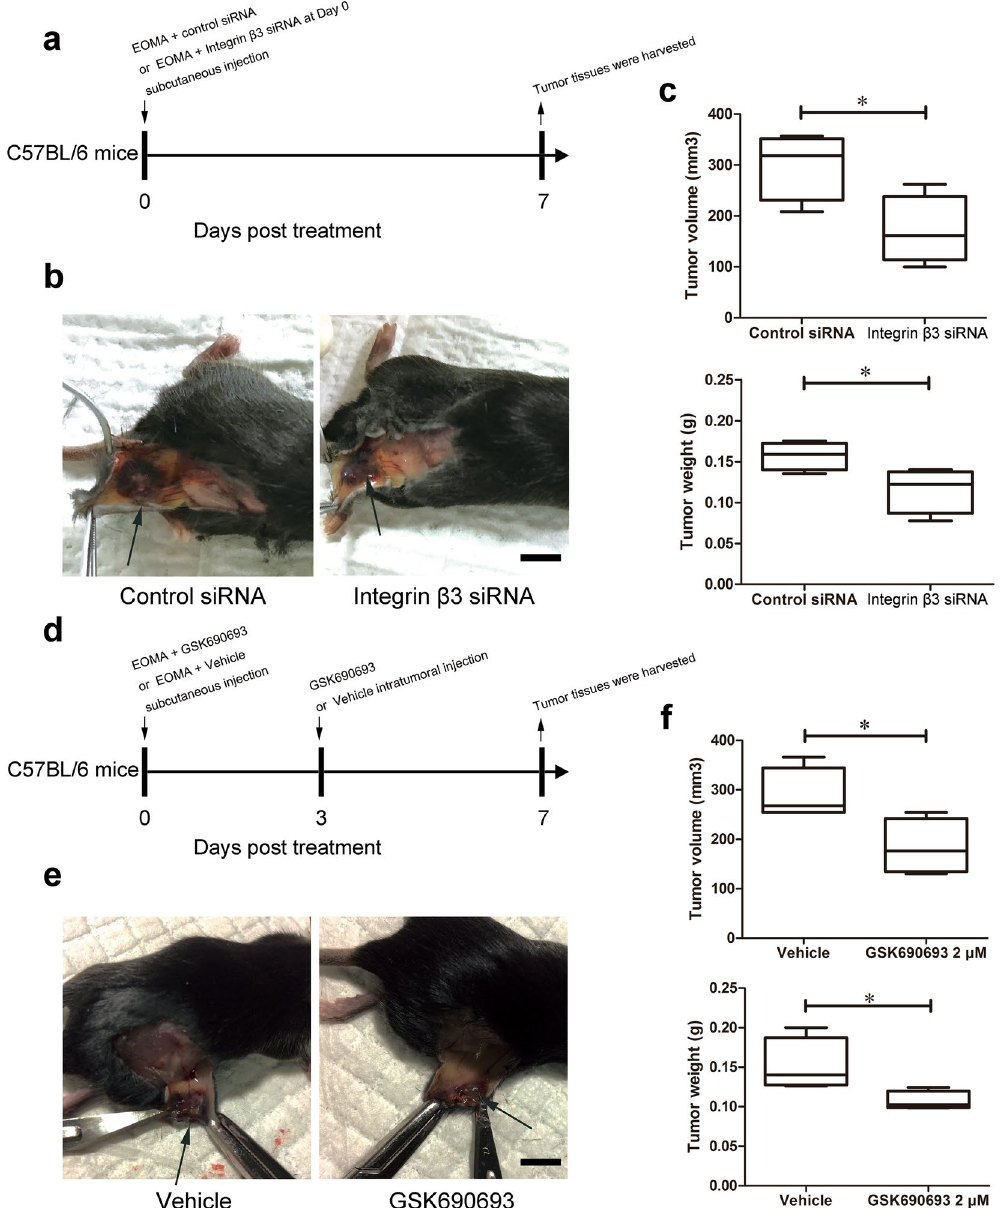
Figure 7. Knockdown of integrin β 3 expression and inhibition of Akt activation attenuated HE growth in vivo . ( a ) EOMA cells were first transfected with control or integrin β 3 siRNA for 4 days, then injected into C57BL/6 J mice on day 0. The tumors were collected on day 7. ( b ) Representative images showing subcutaneous growth of HE in response to the knockdown of integrin β 3. Scale bar, 1 cm. Arrows indicated subcutaneous HE. ( c ) The tumor volumes and weights in response to the knockdown of integrin β 3. ( d ) C57BL/6 J mice were injected with EOMA cells in the presence of GSK690693 or vehicle on day 0, then subjected to an additional intratumoral injection of GSK690693 or vehicle on day 3. Animals were sacrificed and the tumor tissues were harvested on day 7. ( e ) Representative images showing subcutaneous HE in response to Akt inhibition. Scale bar, 1 cm. Arrows indicated subcutaneous HE. ( f ) The tumor volumes and weights in response to Akt inhibition. n = 4, t-test. * P <